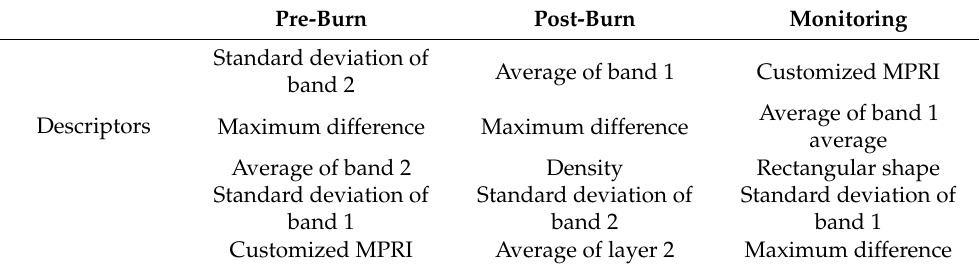
Table 1. Features selected by the optimization function on each classification obtained.